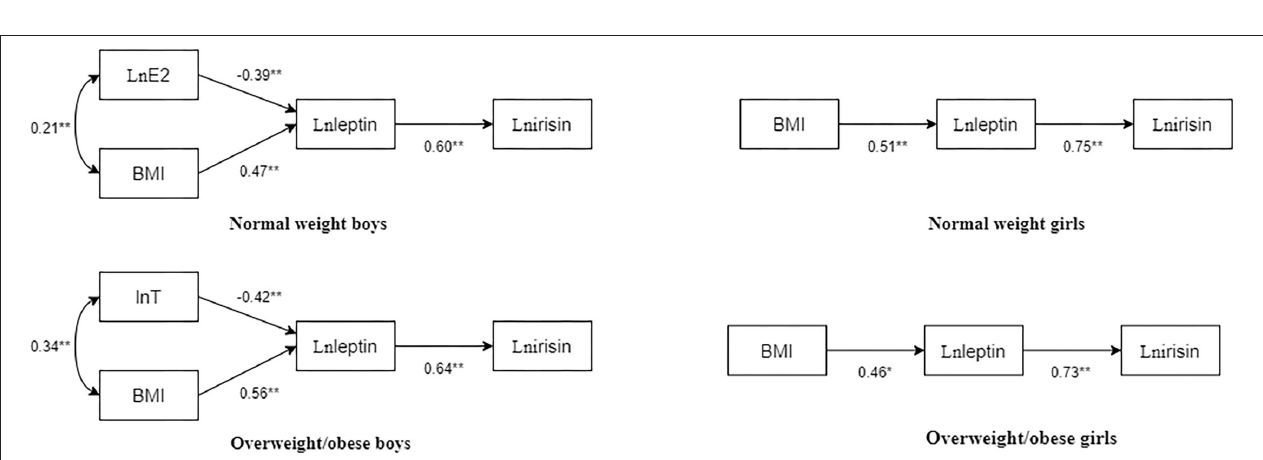
FIGURE 1 | Multifactor regression results of body mass index (BMI), testosterone (T), oestradiol (E2), leptin, and irisin in children and adolescents with different body types after adjusting for age. The dotted line in the figure indicates that the regression result is not statistically significant, whereas the solid line indicates that the regression result is statistically significant. The numbers beside the arrows show the standardized regression coefficients; ** p < 0.01.